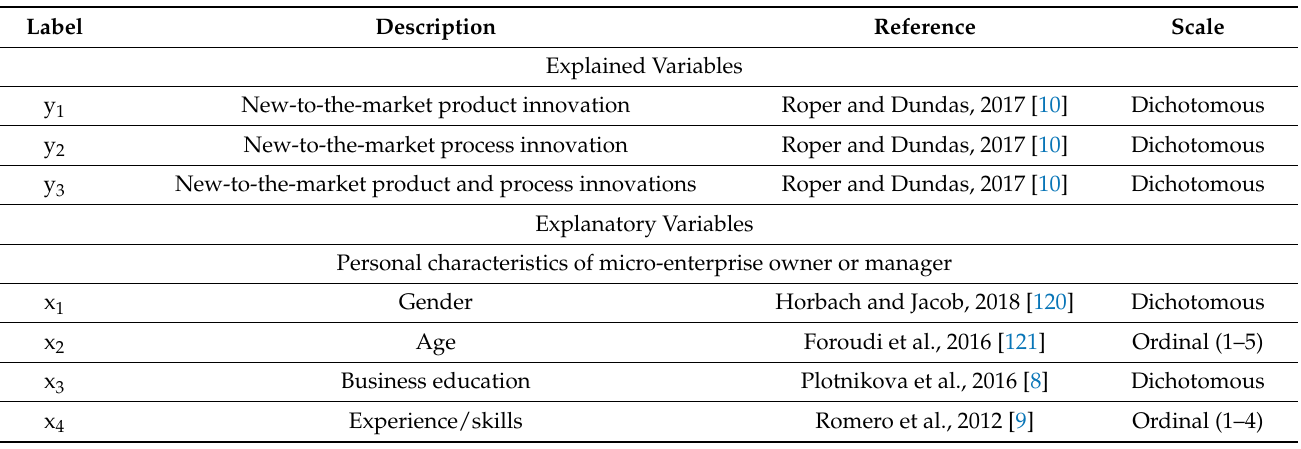
Table 4. Description of